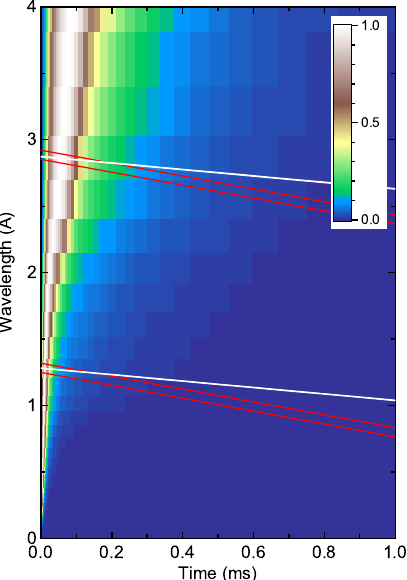
Figure 5. Time-wavelength acceptance diagram of the pulse- shaping chopper (red lines) and the Fermi chopper (white lines) for 10meV and 50meV neutrons. The rotation speed of the pulse-shaping chopper is 300Hz, while that of the Fermi chop- per is 200Hz (10meV) and 300Hz (50meV), respectively. Color map shows the time structure of the moderator at BL01, whose peak intensity is normalized to unity.